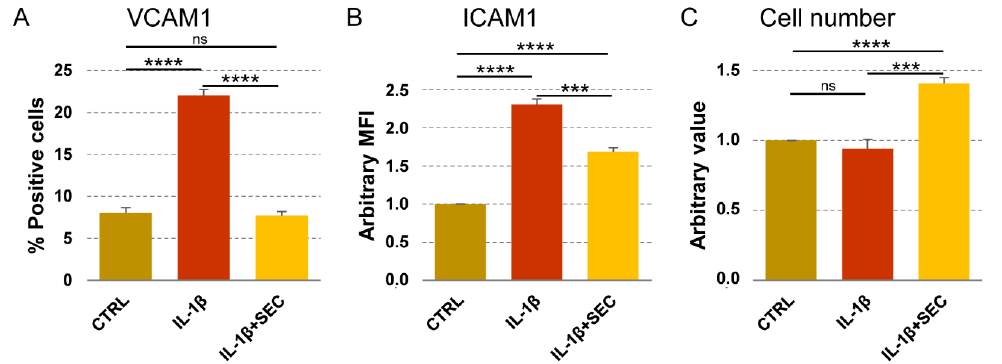
Figure 5. Secretome effects on inflamed chondrocytes. ( A , B ) Chondrocytes (CTRL) were treated with inflammatory cytokine without (IL-1 β ) and with secretome (IL-1 β + SEC). VCAM1 and ICAM1 were detected by flow cytometry. Values on the y -axis show either the percentage of VCAM1-positive cells or the arbitrary amount (defined as Mean Fluorescence Intensity, being 100% chondrocytes positive in all conditions, CTRL set as 1) of ICAM1. N = 3, *** p ≤ 0.001, **** p ≤ 0.0001; ns, not significant. ( C ) Chondrocytes, as previously described, were counted and CTRL values set as 1. N = 3, *** p ≤ 0.001, **** p ≤ 0.0001; ns, not significant.